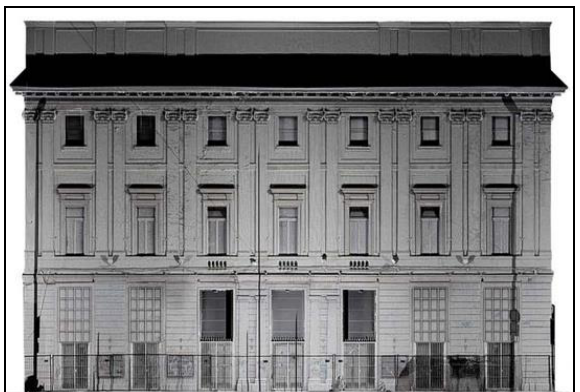
Figure 5. Point cloud of the front of the Lyric Theatre Source: Municipality of Milan